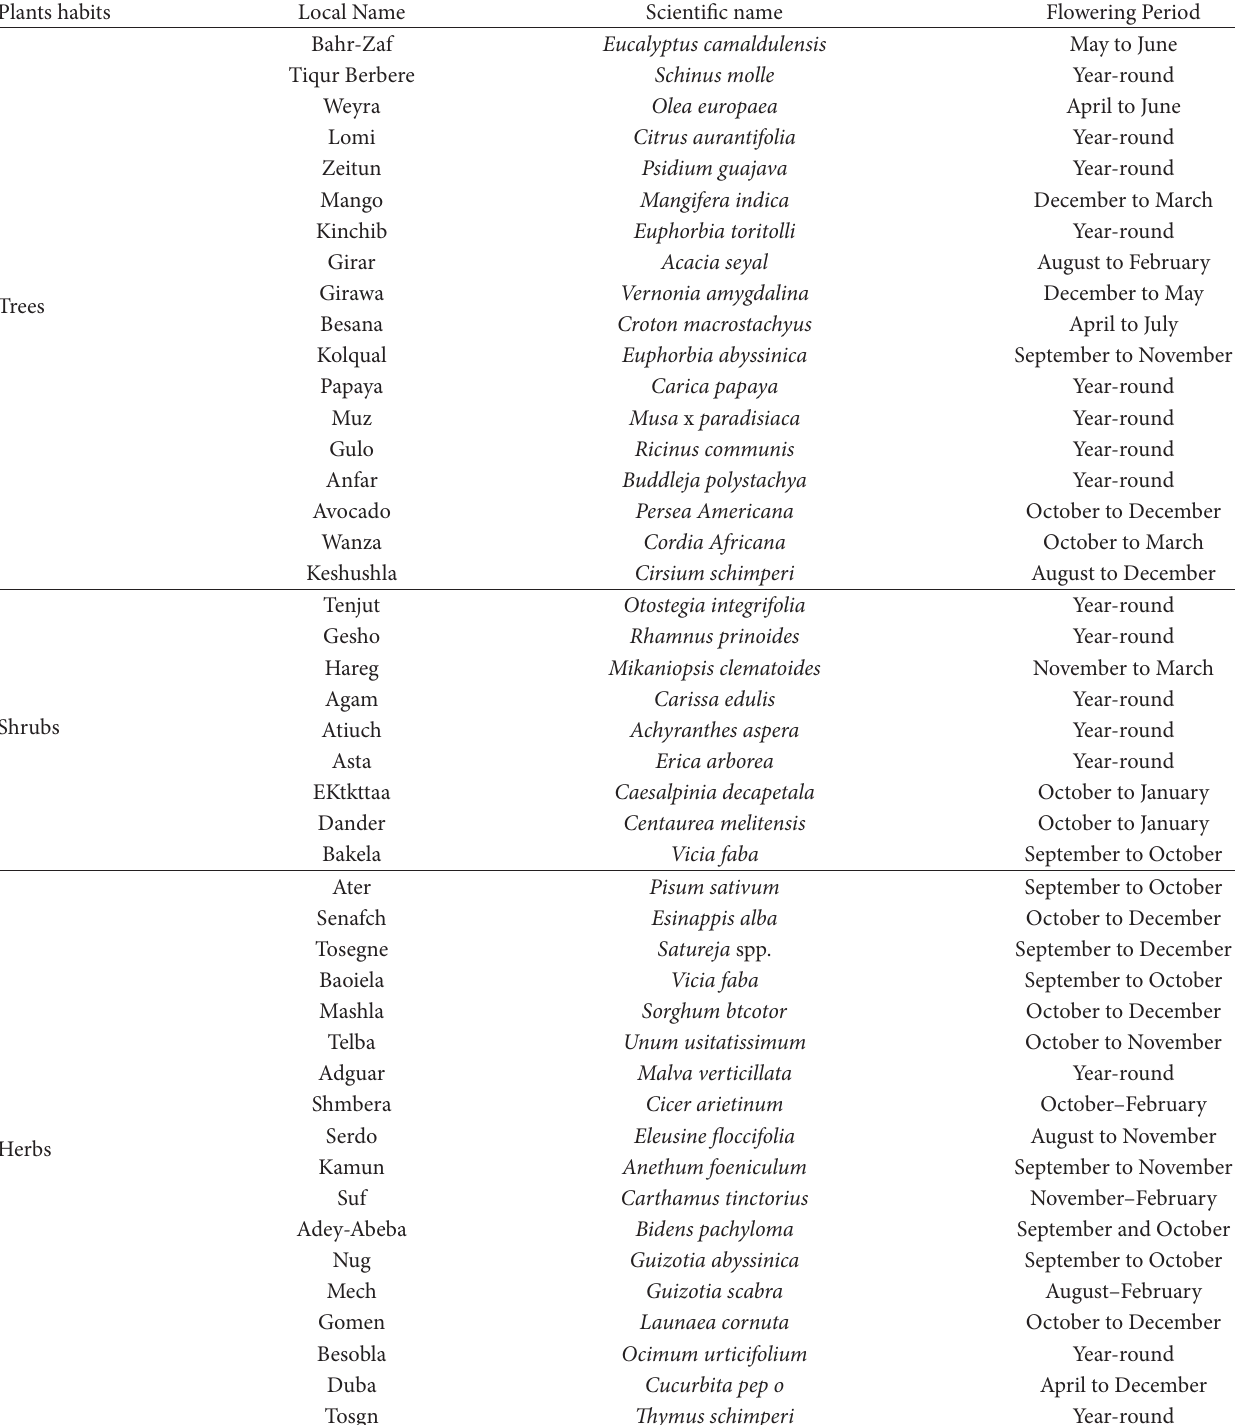
Table 7: Flowering plant species used as nectar source by honeybees and their flowering period. Plants